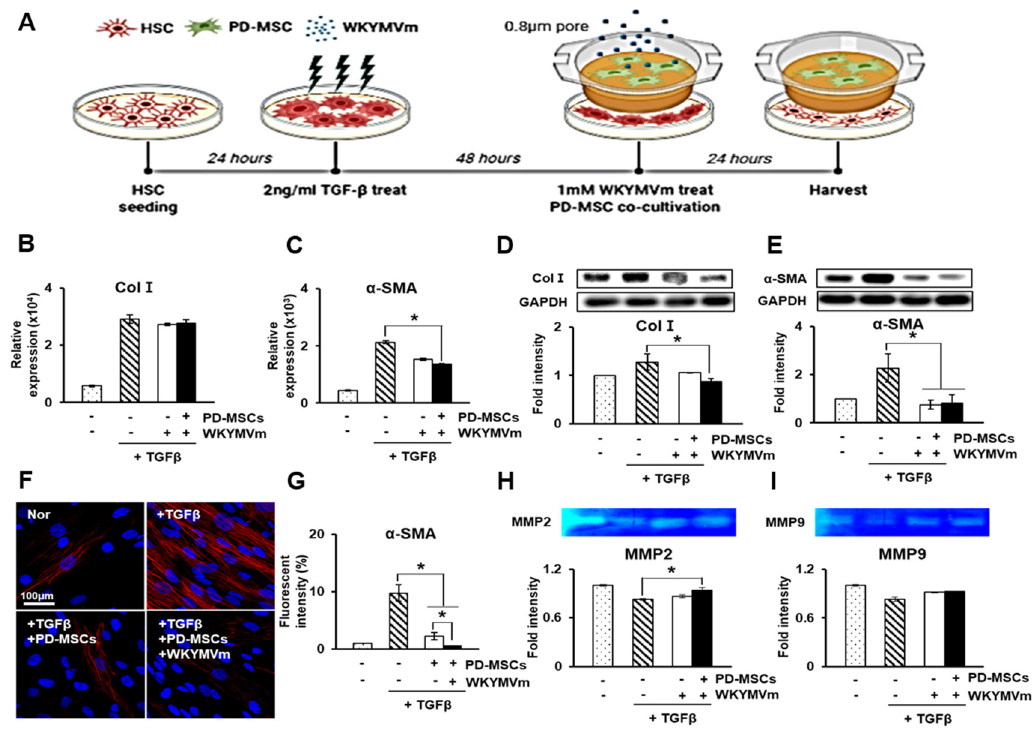
Figure 5. PD-MSCs combined with WKYMVm inhibit HSC activation in vitro. ( A ) Schematic figure of HSC in vitro modeling. mRNA expression of Col I ( B ) and α -SMA ( C ) in HSCs treated with TGF- β shown by qRT-PCR. Protein levels of Col I ( D ) and α -SMA ( E ) shown by Western blots. ( F ) α -SMA expression in HSCs treated with TGF- β , as determined by immunofluorescence. Scale bar = 100 μ m. ( G ) Fluorescence intensity of α -SMA, as determined by immunofluorescence. Enzyme activity of MMP-2 ( H ) and MMP-9 ( I ) in the culture supernatant of HSCs treated with TGF- β shown by gelatin zymography. n = 3 per group, mean ± SD, *, p < 0.05 by t tests.